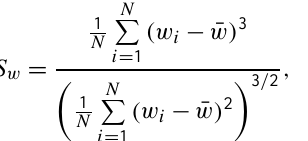
Fig. 3. Example of vertically resolved (a) w estimates [ms − 1 ], warm (cold) contours indicate ascending (descending) motions; (b) w variance ( σ 2 w ) [m 2 s − 2 ]; and (c) w skewness ( S w ) from 27 Au- gust 2008. Both σ 2 w and S w are calculated for a 20min moving win- dow at each radar range